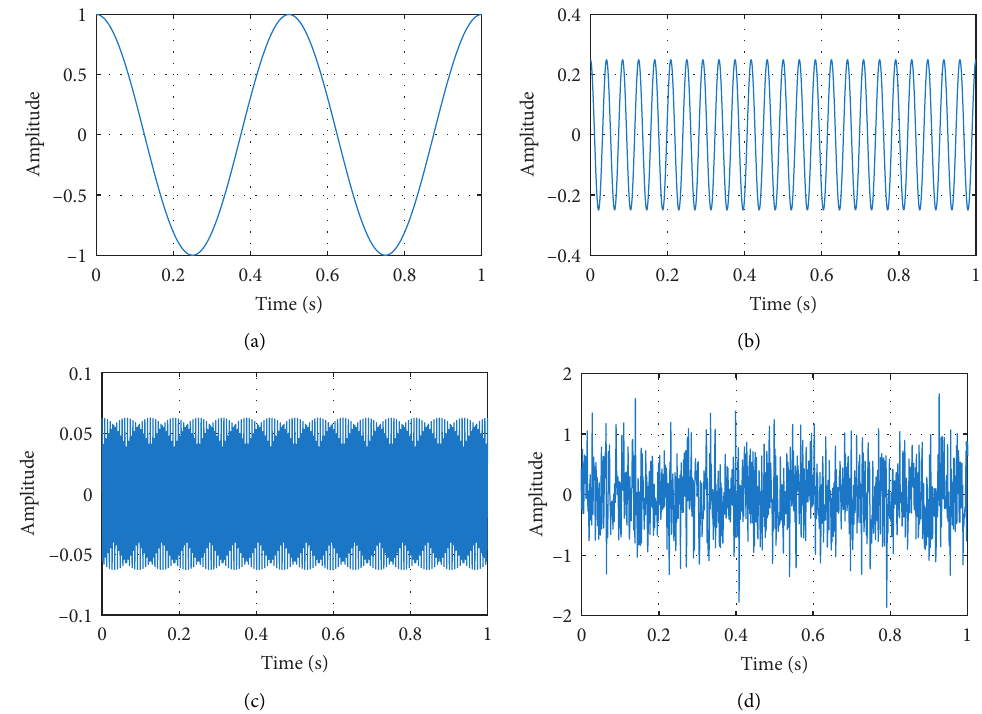
Figure 3: Each part of the simulation signal: (a) harmonic signal y